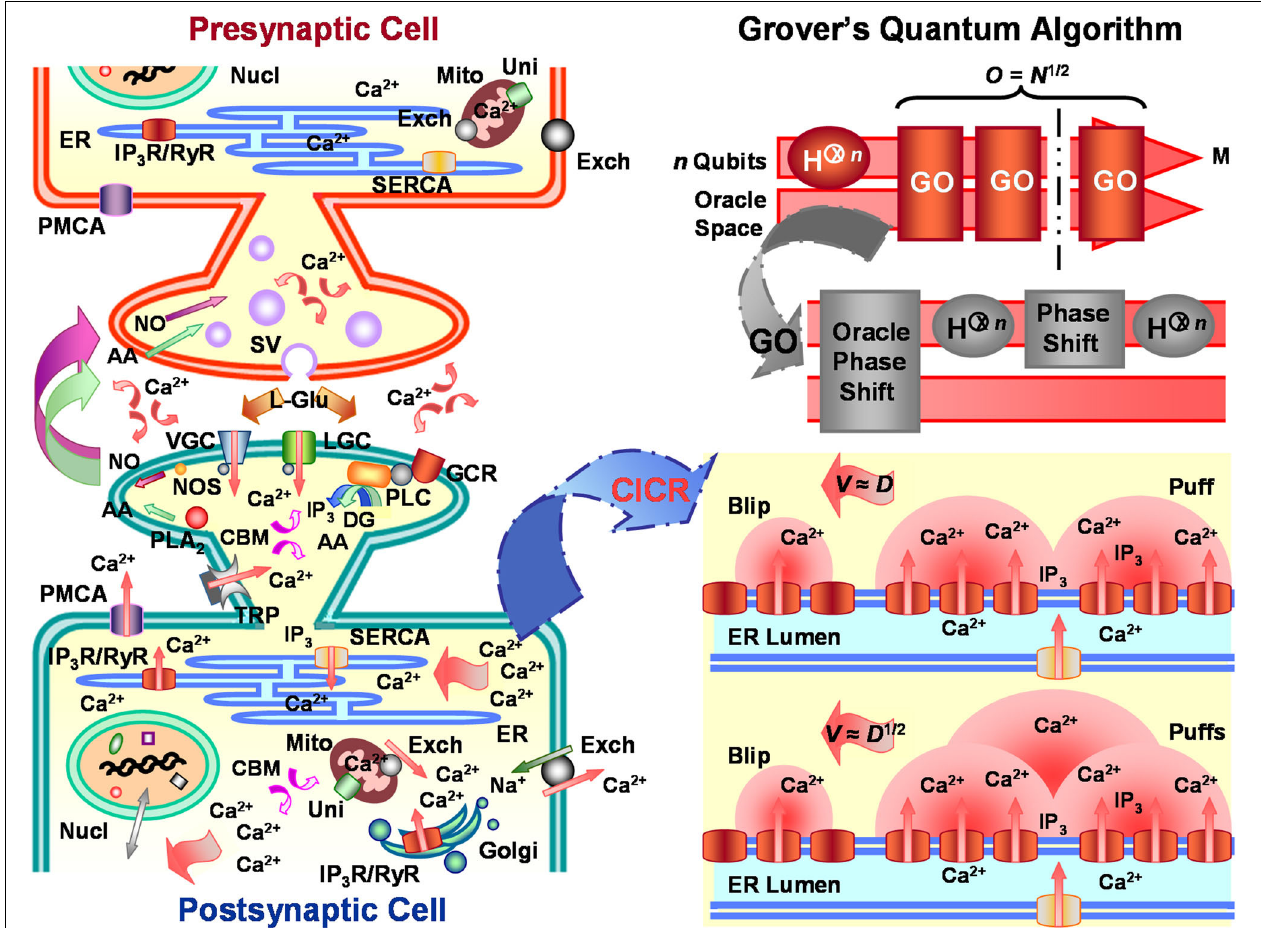
Whereas, faster continuous Ca 2 + waves and the information they transmit move at velocities proportional to the square-root of the classical Ca 2 + diffusion coefficient. Coefficient D of continuous waves for either intercluster or intracluster diffusion is assumed to be up to orders of magnitude greater than that for saltatory waves. The quadratic disparity in the velocities of saltatory and continuous waves corresponds to the root-rate increase of information processing by Grover’s quantum algorithm over classical algorithms. Upper right panel shows schematic of